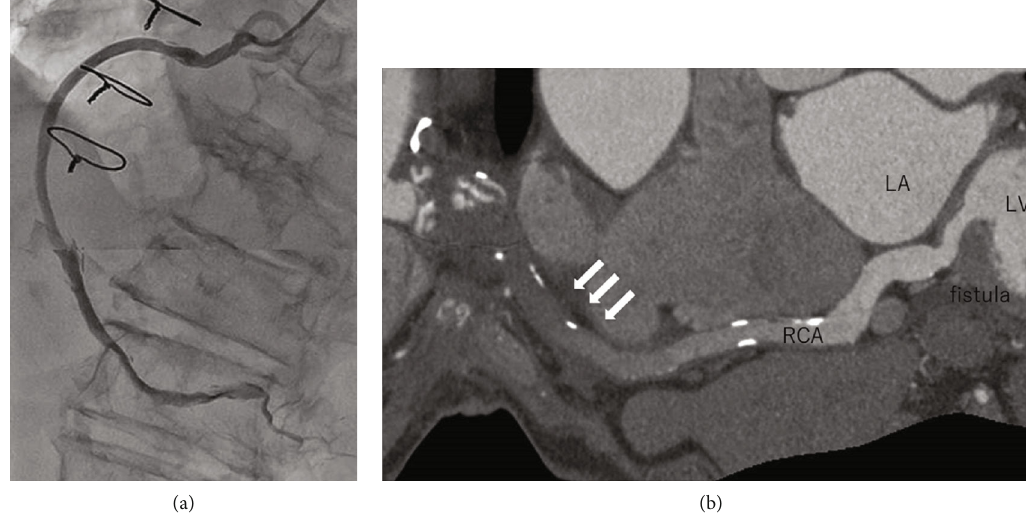
Figure 4: (a, b) Postoperative coronary angiography (a) and MDCT